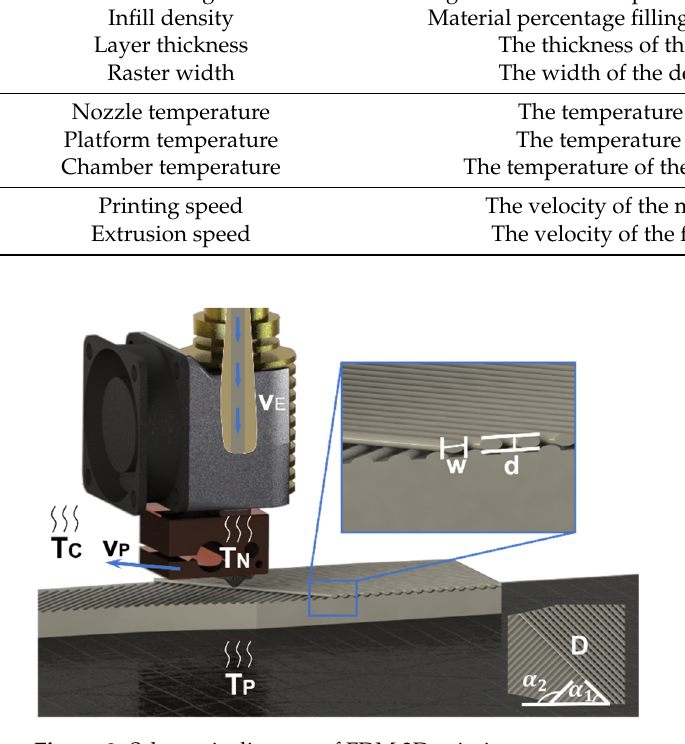
Figure 2. Schematic diagram of FDM 3D printing parameters: raster angle ( α 1 / α 2 ), infill density (D), layer thickness (d), raster width (w), nozzle temperature (T N ), platform temperature (T P ), chamber temperature (T C ), printing speed (v P ), extrusion speed (v E